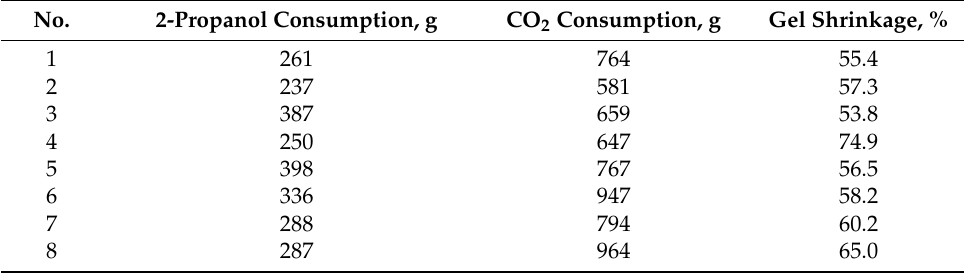
Table 3. Consumption of components and gel shrinkage during the solvent exchange process through multiphase